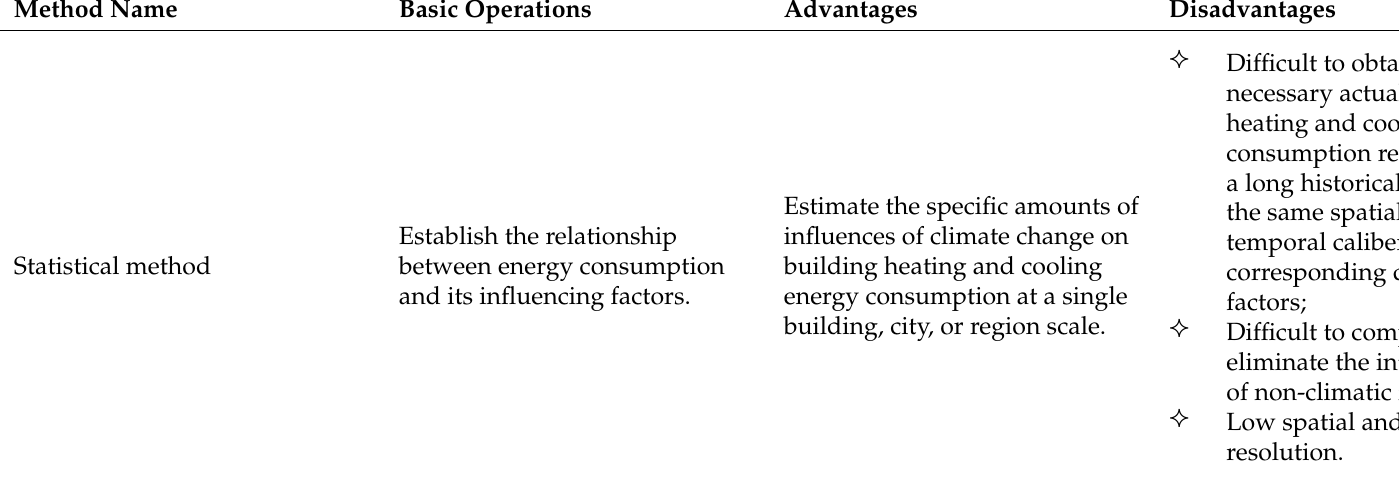
Table 1. Basic operations, advantages, and disadvantages of different methods used to estimate the impacts of climate change on the energy consumption of building heating and cooling.